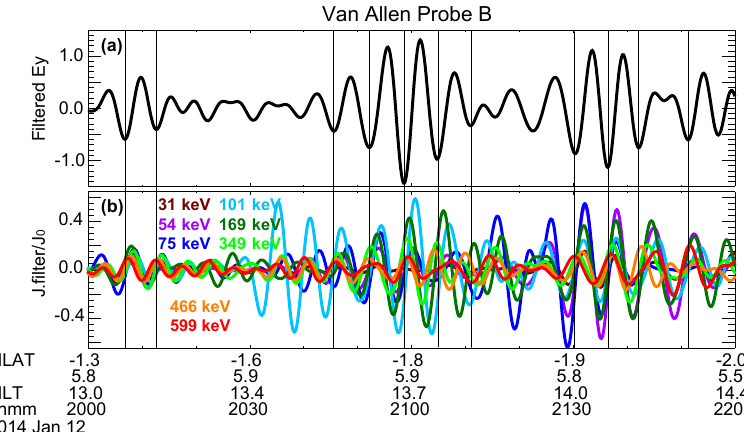
Figure 5. The correlation of the filtered (1.5–4mHz) E y component of ULF waves (a) and the energetic electron fluxes at different energy channels (b) . The electron fluxes show the modulation in the similar period to that of E y , but exhibit an energy-dependent phase shift with respect to E y